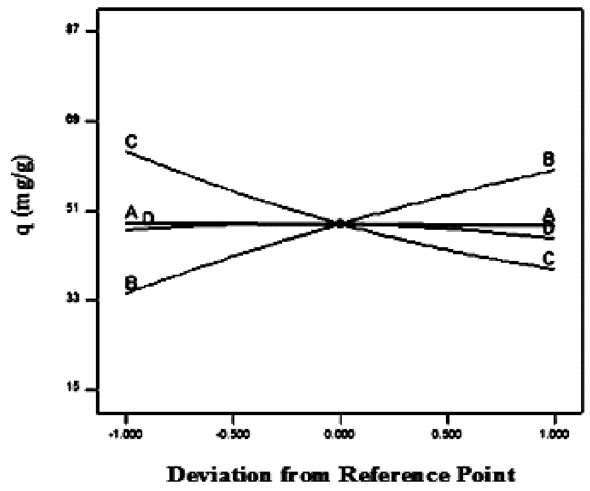
Figure 8. Perturbation plot for strontium (II) biosorption on Mg-treated sargassum sp.